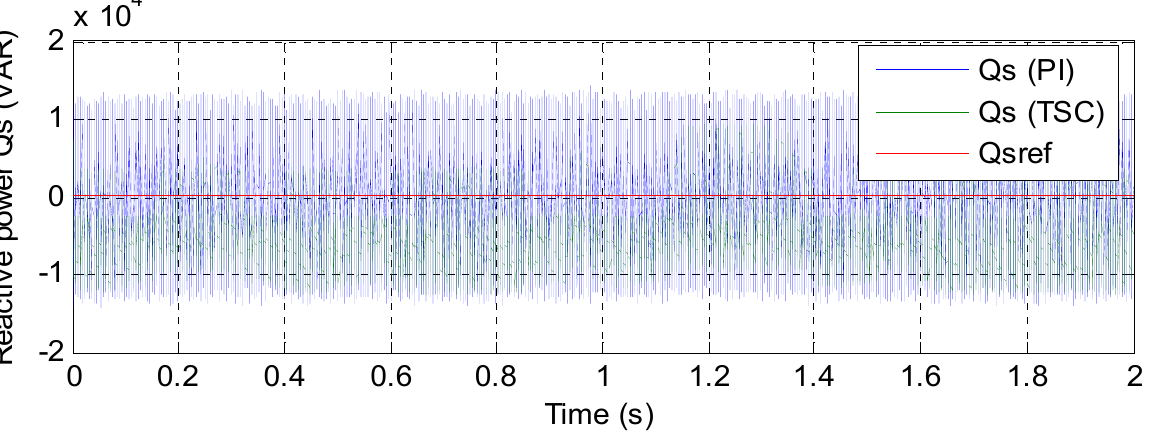
Figure 9. Reactive power.